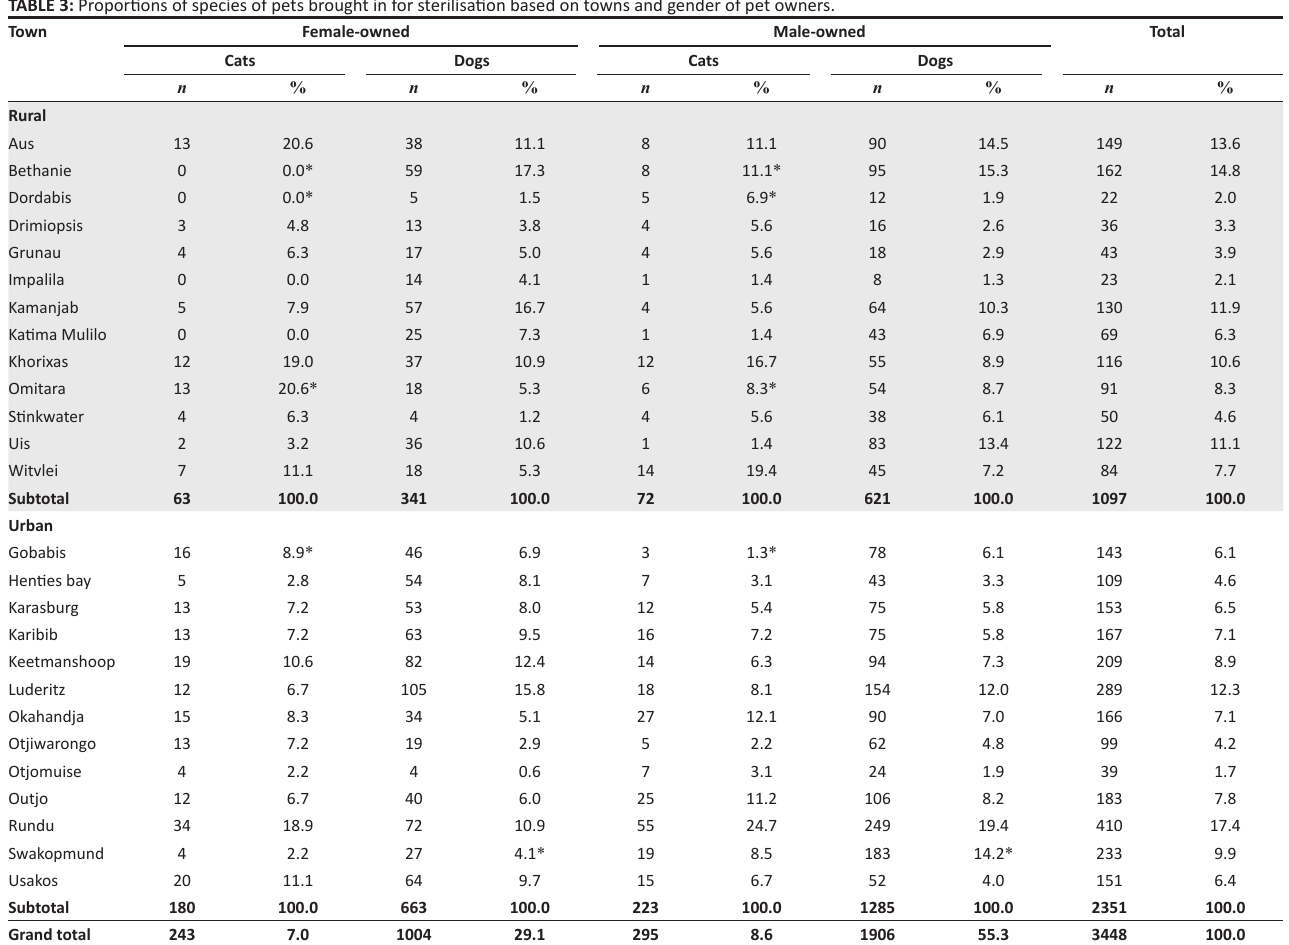
TABLE 3: Proportions of species of pets brought in for sterilisation based on towns and gender of pet owners.